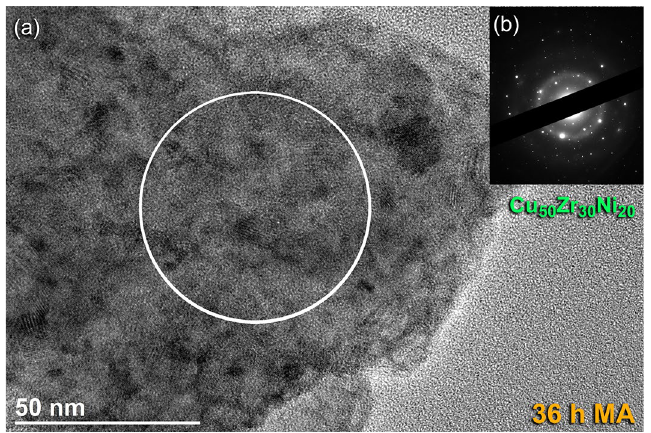
Figure 8. Local structural characteristics beyond the nano-level of 36 h-Cu 50 Zr 30 Ni 20 powders. ( a ) Bright field image (BFI), and corresponding ( b ) SADP of Cu 50 Zr 30 Ni 20 powders obtained after milling for 36 h of MA time.